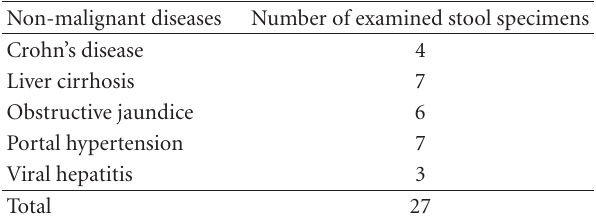
Table 2: Stool specimens from non-malignant gastrointestinal dis-